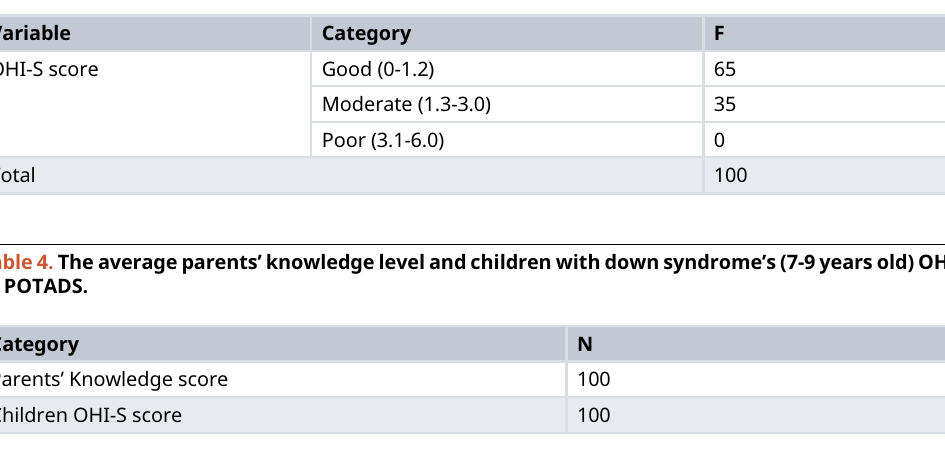
Table 3. OHI-S score of children with down syndrome (7-9 years old) in POTADS Surabaya.